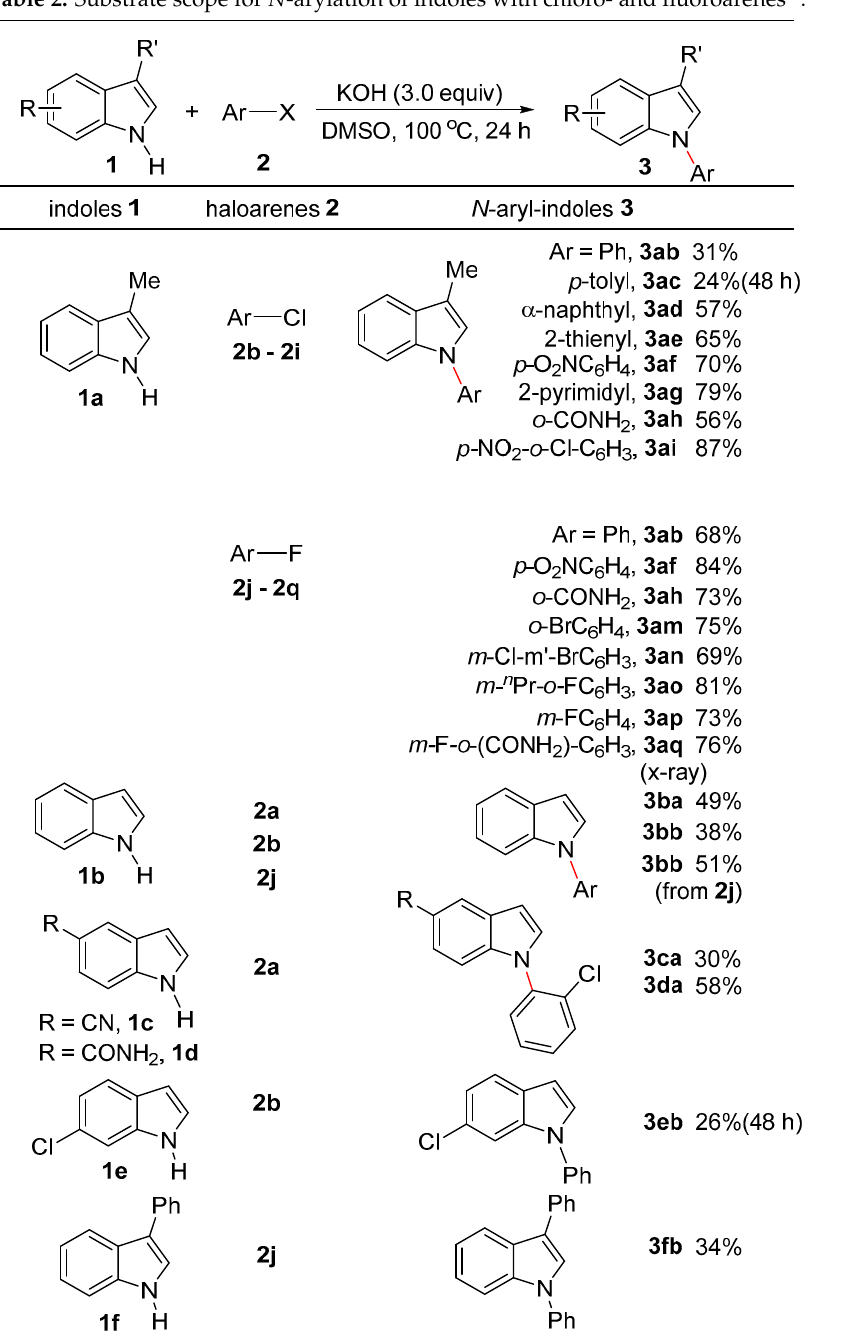
Table 2. Substrate scope for N -arylation of indoles with chloro- and fluoroarenes a